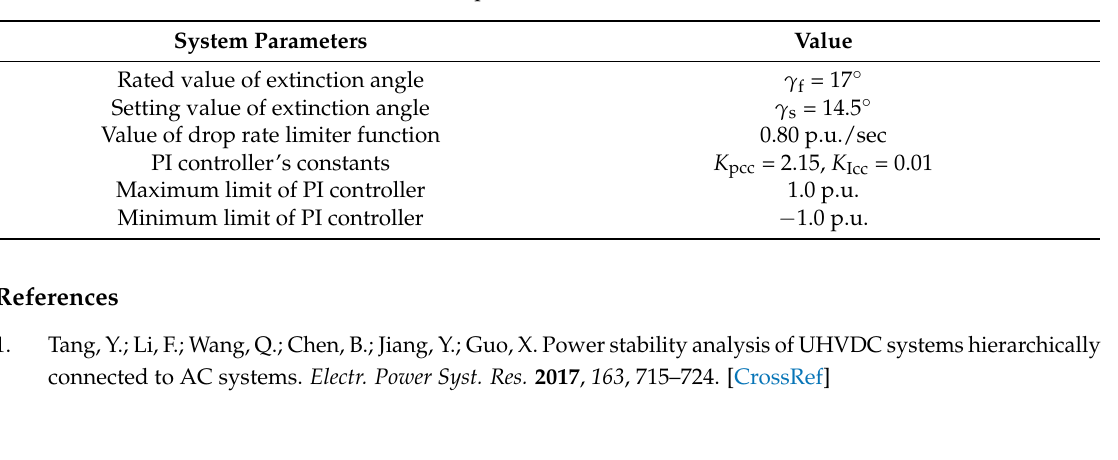
Table A3. Parameter Specifications of Coordinated